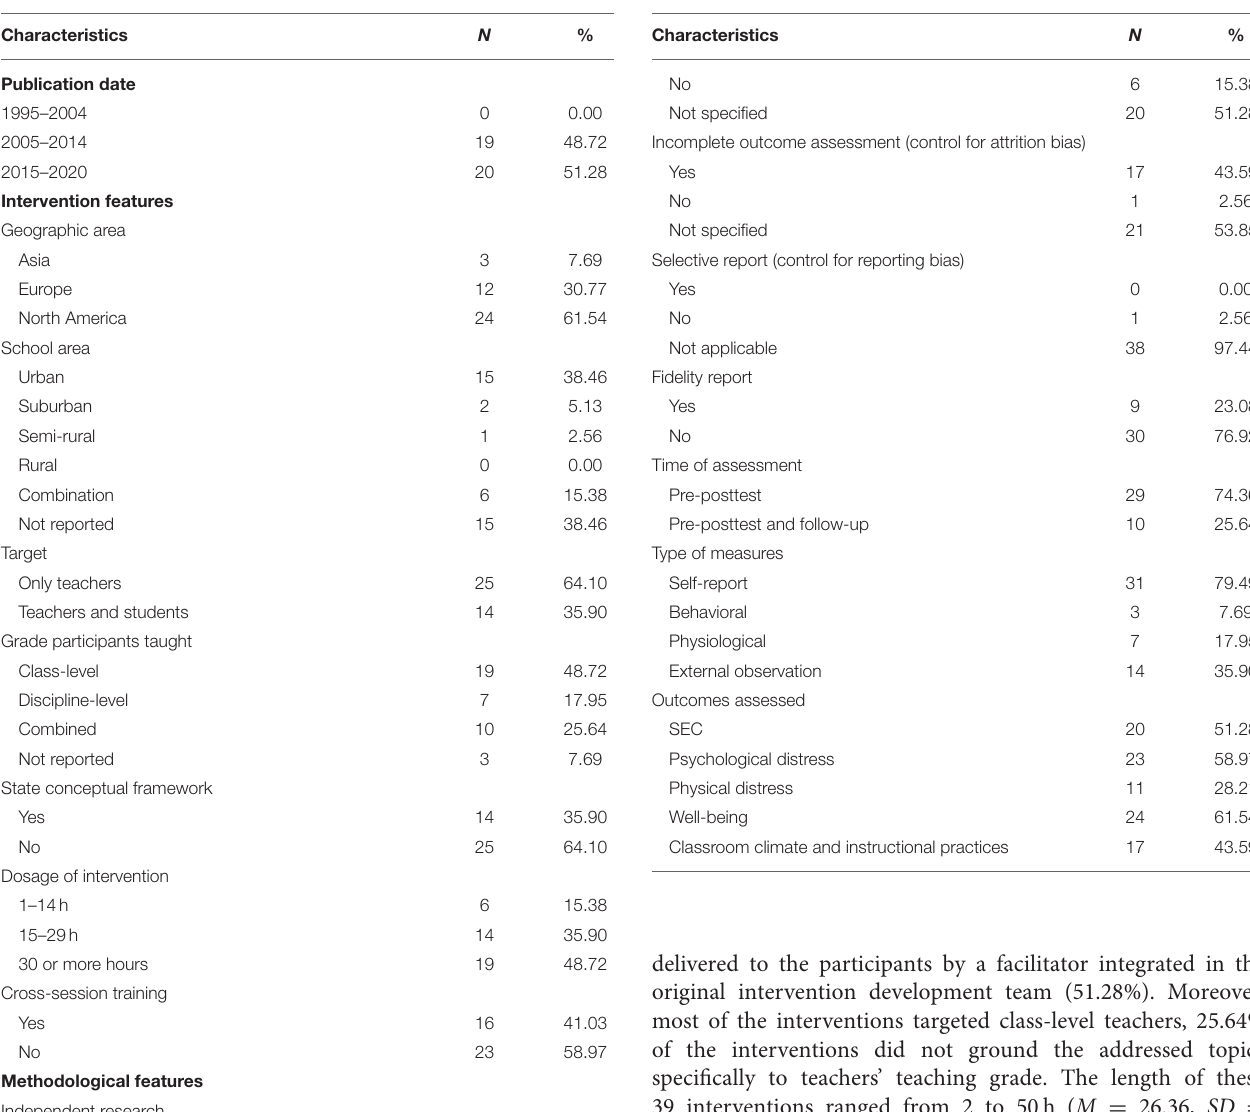
TABLE 3 | Report on general characteristics of the 39 reviewed